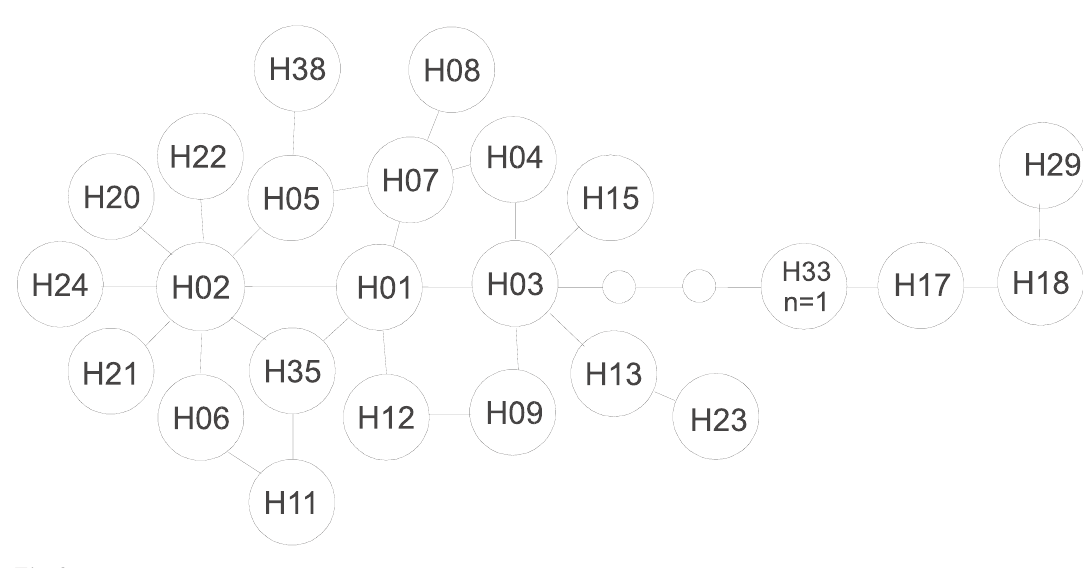
Fig. 3 Haplotype network for common and connecting beluga mtDNA control region sequences reduced from the network in Brown Gladden et al. (1997). Small circles represent halotypes that do not exist or have not yet been found. Each connection line represents a